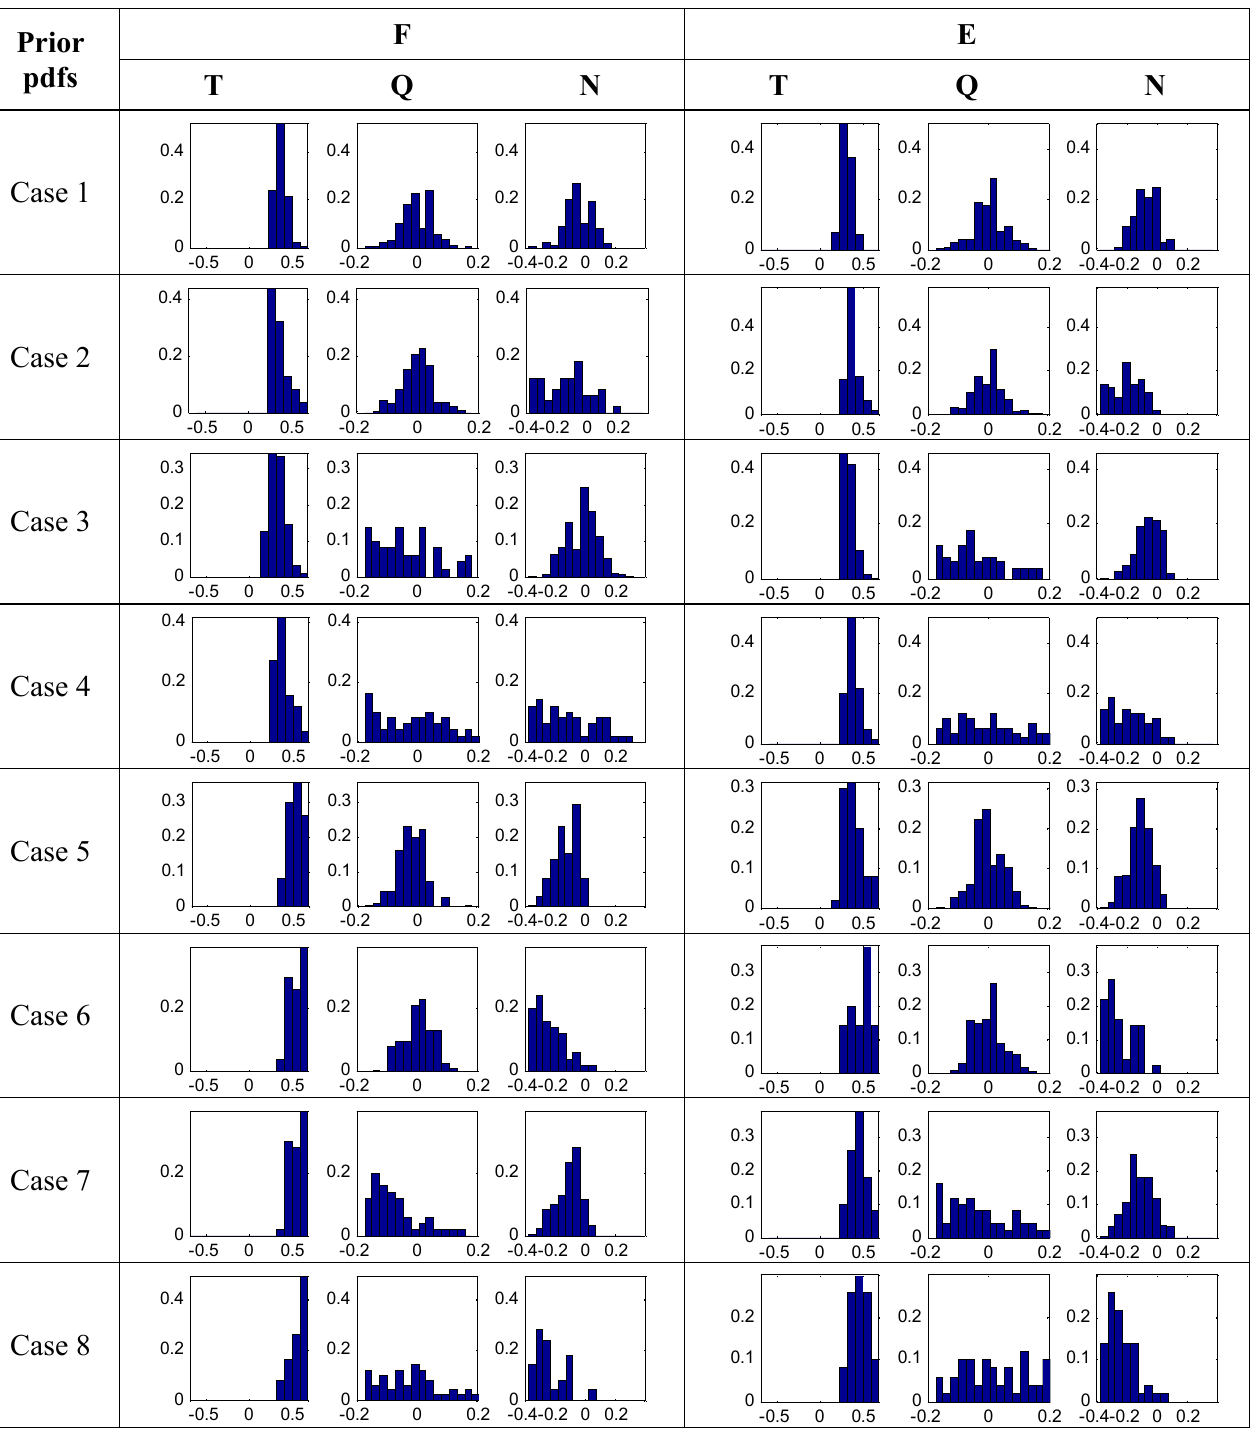
Figure 4. The posterior pdfs of model variables for the top 1% of the E and F likelihood measures. The x-axis is the change of uncertainty in the model variable, and the y-axis indicates the